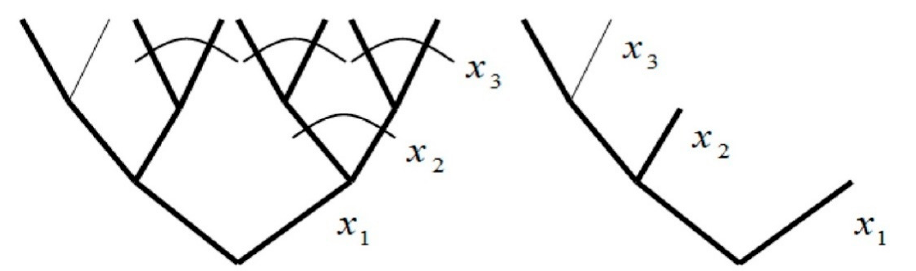
Figure 5. Logic tree and simplified logic tree.